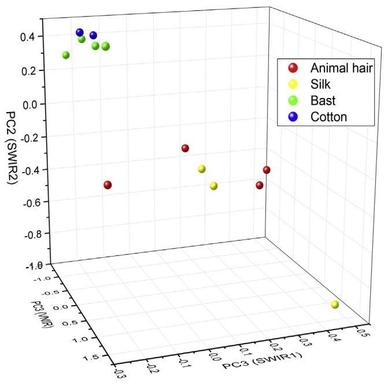
PCA score plots of textile samples of four different fiber types (3 selected PCs).